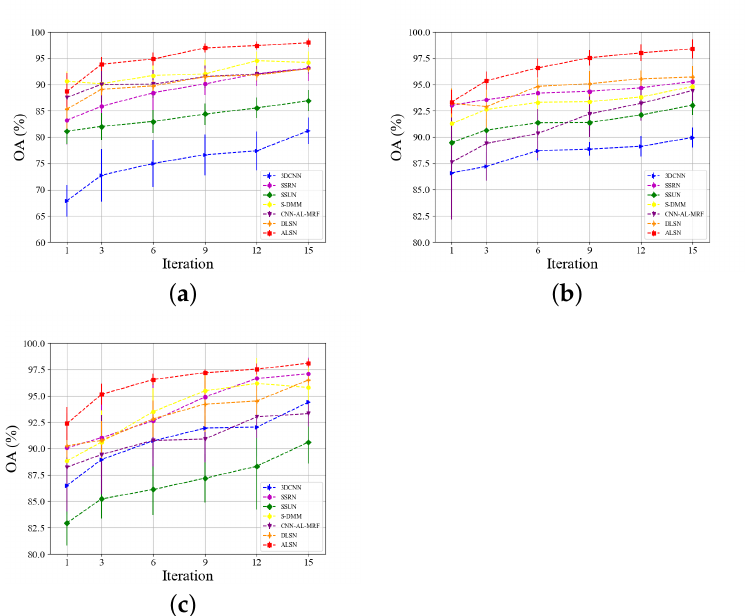
Figure 15. Evolution of OA obtained by different methods as a function of iteration. ( a ) PaivaU, ( b ) Salinas, ( c ) YRD.